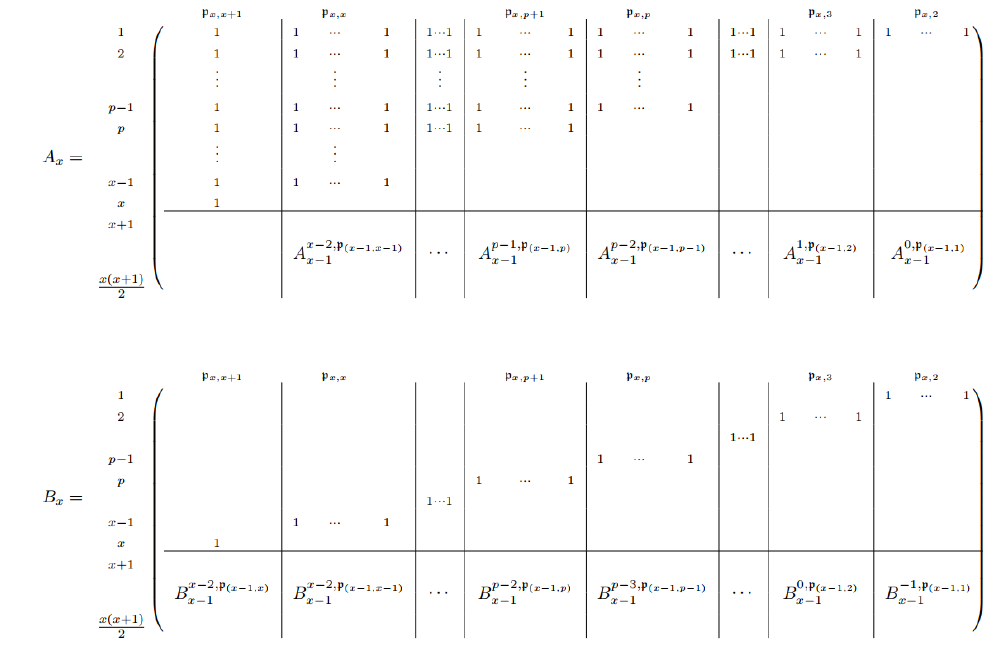
Figure 3. Matrices A x and B x whose entries are defined by identities